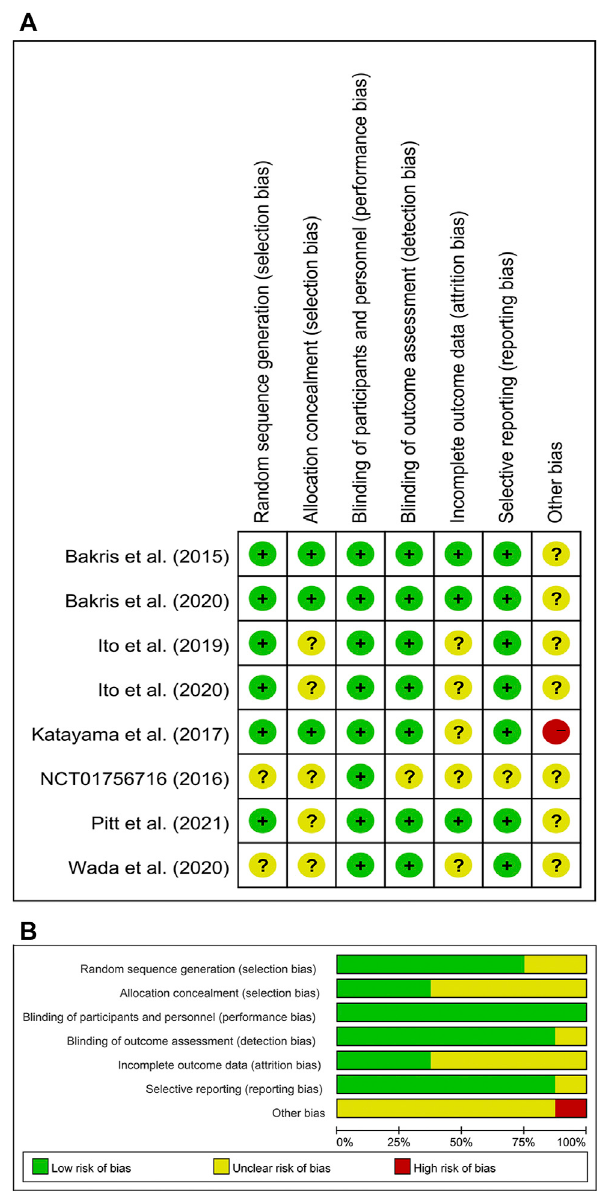
FIGURE2|(A) Riskofbiassummaryforincludedstudies,showingeach risk of bias item for every included study. (B) Risk of bias graph presenting each risk of bias item as percentages across all included